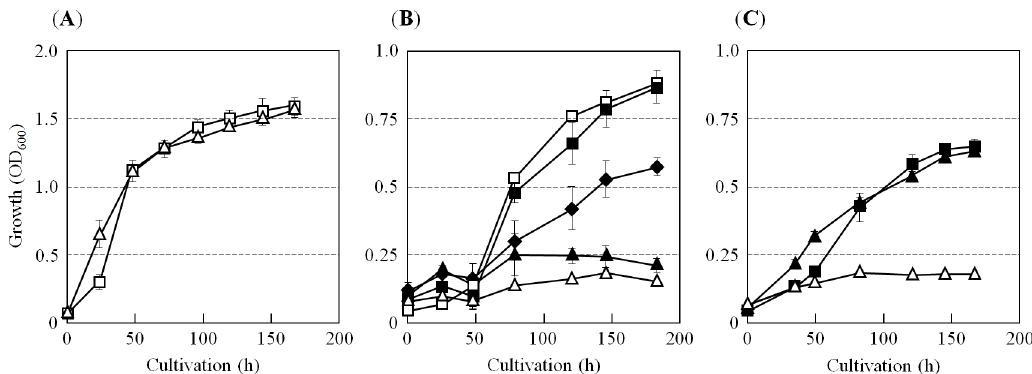
Fig 2. Anaerobic growth variant phenotype of the Δ ahbD variant of H . volcanii . The ahbD deletionvariant of H . volcanii ,strain A02 (open triangles), and the parent strain H26 (open squares)were cultivatedunder aerobic or anaerobicconditions. As shown in ( A ), strain A02 grew actively under aerobicconditionswith a similar growth rate to that observedin strain H26. Under the denitrifying condition,growth of the strain A02 was strongly inhibitedas shown in ( B ). Denitrifyinggrowth of strain A02 was not recovered by addingprotoheme up to 5 μ M (closed triangles) using the stock solution of protoheme dissolvedin the Tris-HCl buffer. The growth was restored in some extent by further addition of 1 mM DMSO to the medium (closed diamonds), the OD 600 value reachedapproximately 0.6. Denitrifyinggrowth of strain H26 was not affected by additionof 5 μ M protoheme (DMSO was not added,closed squares). As indicatedin ( C ), with supplementation of 5 μ M protoheme, anaerobicgrowth of the strain A02 by DMSO-respiration(closedtriangles) was restored to a similar level to that of strain H26 supplemented with protoheme (closedsquares). Experiments were performed independently three times. Error bars represent